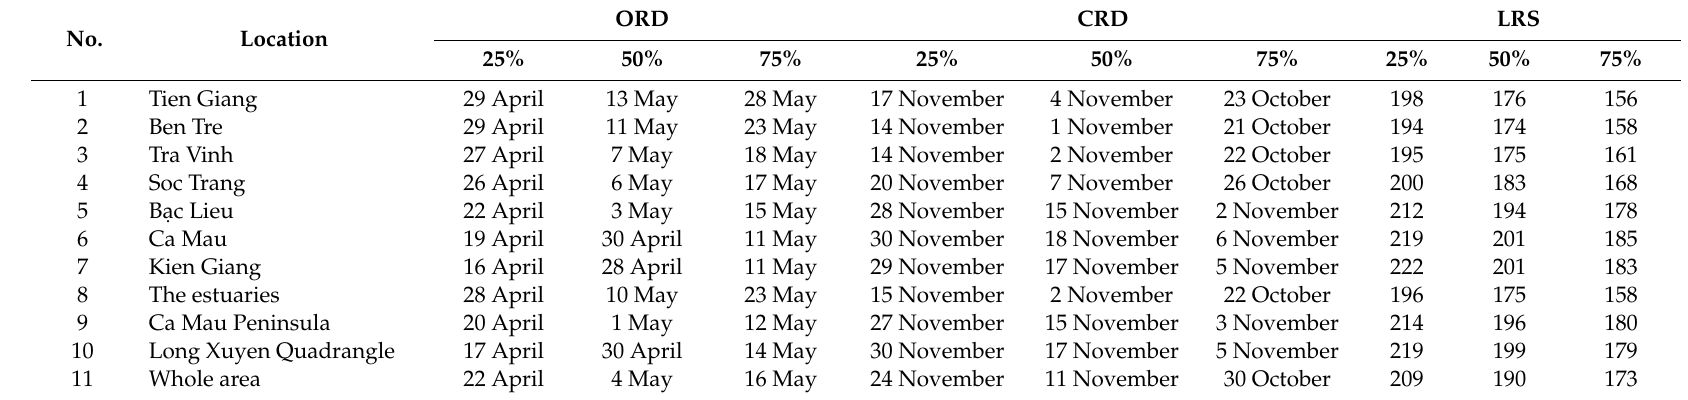
Table A1. Characteristics of the date of onset of the rainy season, ORD, the cessation date of the rainy season (CRD), and the length of the rainy season (LRS) at di ff erent probability